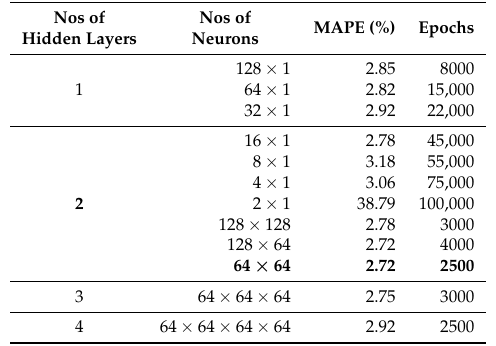
Table 5. Selection of hidden layers, nodes and epochs for Scenario 1.